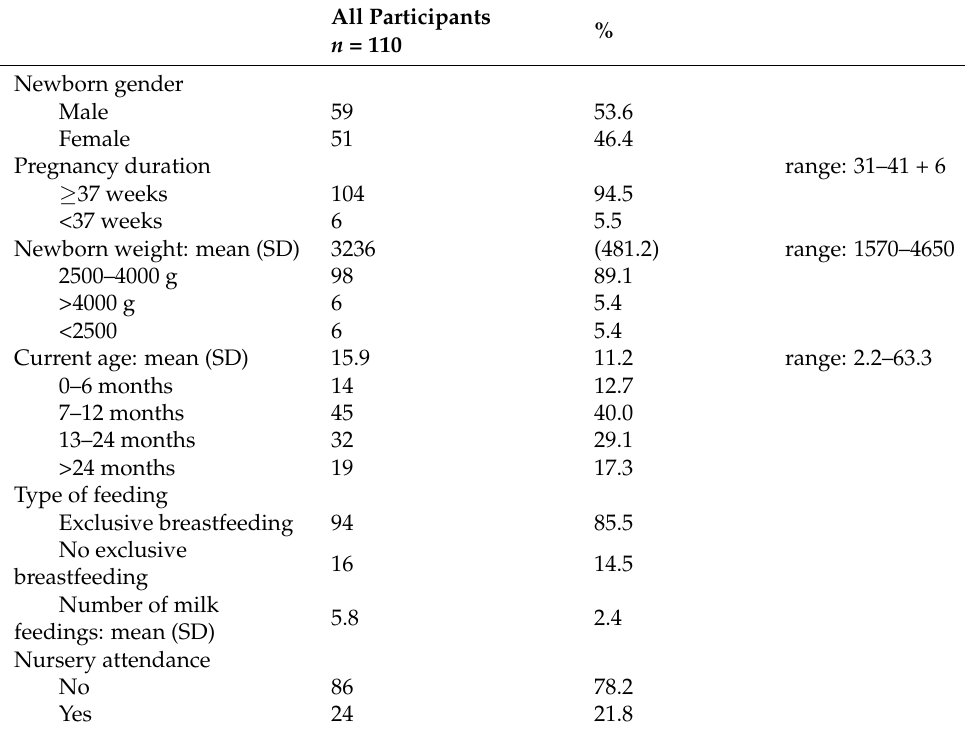
Table 2. Descriptive analysis of breastfed infants included during the study period (2021).